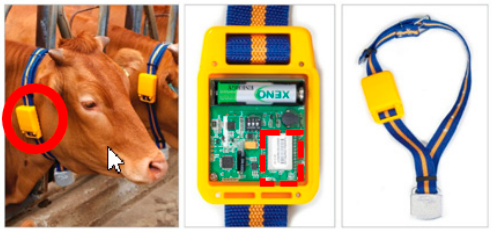
Figure 1. Cattle necklace-shaped sensor board and case.